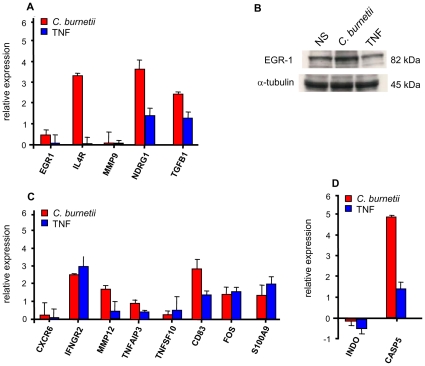
Real time RT-PCR and western blot analysis.BeWo cells were stimulated with C. burnetii for 6 h. A, C and D; RNA was extracted and real time RT-PCR was performed. Results expressed in relative expression (stimulated vs. unstimulated conditions) represent the mean ± SEM of 3 independent experiments. B, Western blot analysis was performed using specific mAbs for α-tubulin and EGR-1, and bands were revealed by chemoluminescence. Their intensity was determined by densitometry and represented the mean of three experiments.